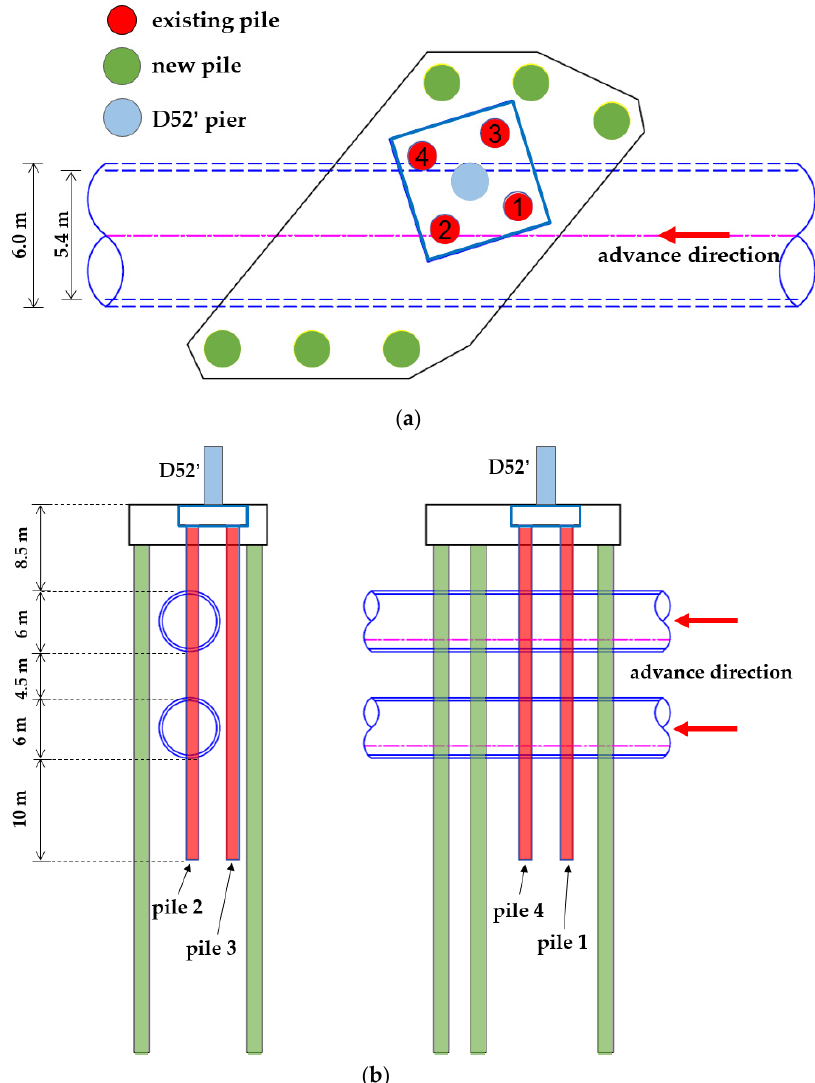
Table 1. The relative position of the piles and tunnels is shown in Figure 2.